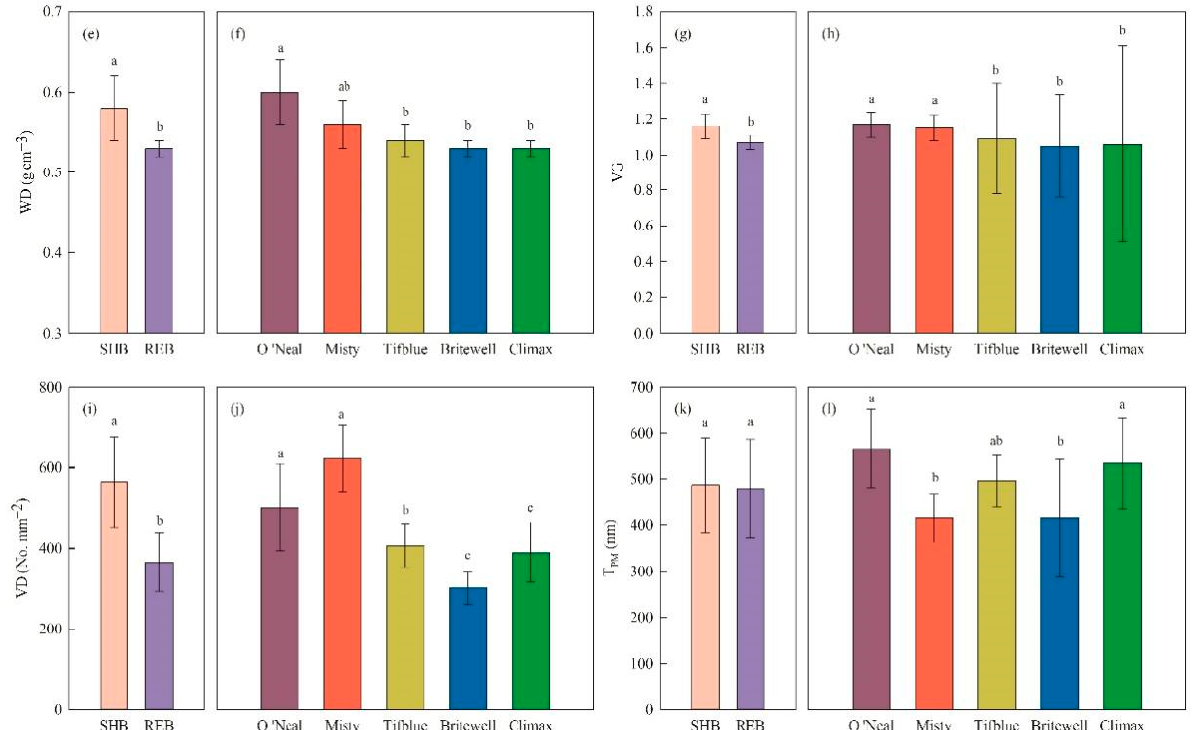
Figure 2. Comparison of sapwood hydraulic conductivity (K S , ( a , b )), vessel diameter (D V , ( c , d )), wood density (WD, ( e , f )), vessel-grouping index (VG, ( g , h )), vessel density (VD, ( i , j )), and pit membrane thickness (T PM , ( k , l )) in five cultivars belonging to southern highbush and rabbiteye blueberries. SHB data represent the means of two southern highbush blueberry cultivars, including O’Neal and Misty, and REB data represent the means of three rabbiteye blueberry cultivars, including Britewell, Climax, and Tifblue. Different lowercase letters indicate statistically significant differences in traits among cultivars ( p < 0.05), while same lowercase letters represent no significant differences in traits among cultivars ( p > 0.05).